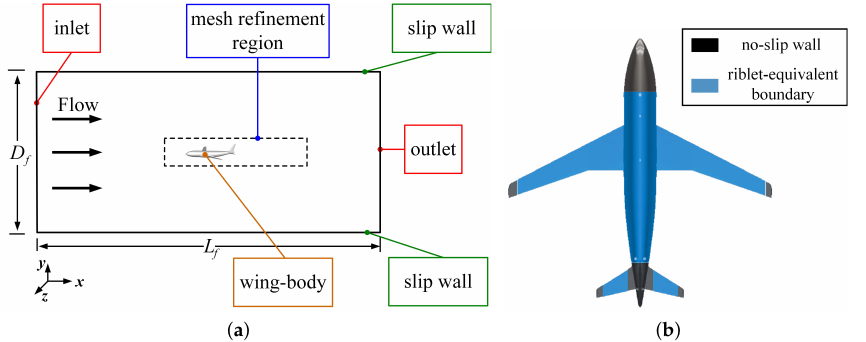
Figure 13. Computational domains and boundary conditions. ( a ) computational domain and coordi- nates; ( b ) wall boundary set for the ribleted